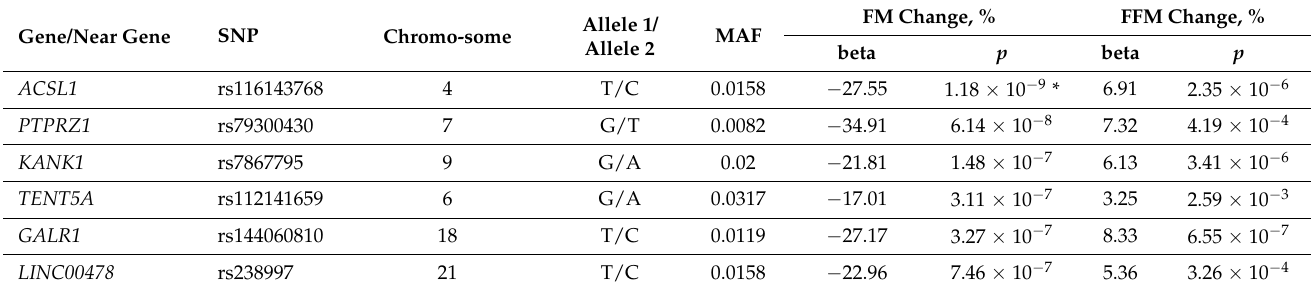
Table 2. Summary statistics of the top SNPs associated with changes in body